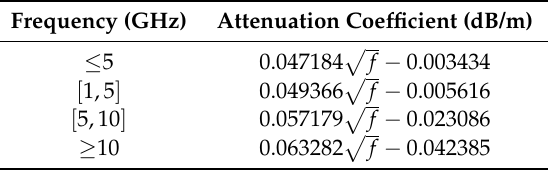
Table 4. UT141 cable interpolated